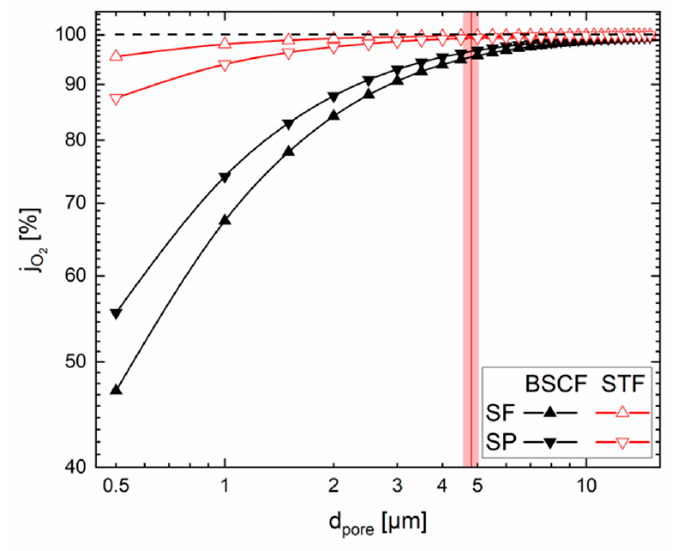
Figure 4. Influence of the pore diameter; vertical red line and the red area show the value used in this work and the ± 5% deviation of the sensitivity analysis.